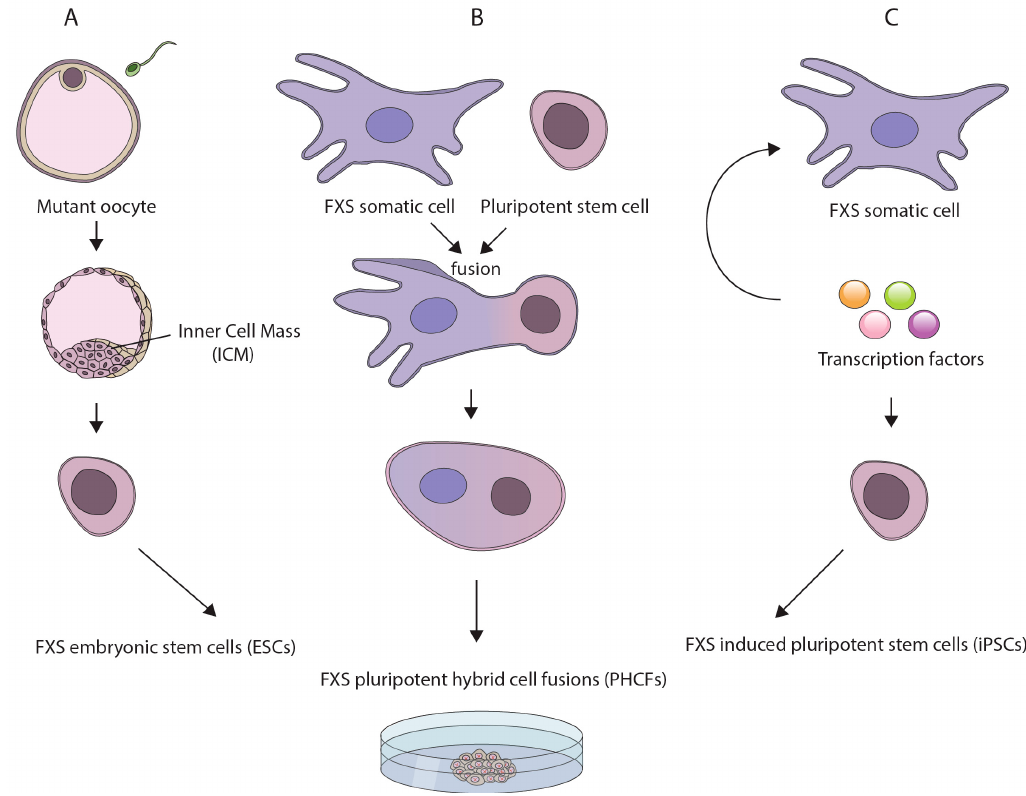
Figure 1. Currently available pluripotent stem cell (PSCs)-based models for investigating the underlying mechanisms for fragile X syndrome (FXS): ( A ) human embryonic stem cell (hESC) lines derived directly from genetically affected FXS embryos following preimplantation genetic diagnosis procedures; ( B ) reprogramming of somatic cells from patients by whole cell/microcell fusion with a pluripotent stem cell, leading to the creation of pluripotent hybrid cell fusions (PHCFs); and ( C ) induced pluripotent cells (iPSCs) derived from patients’ somatic cells by over-expression of a defined set of transcription factors.